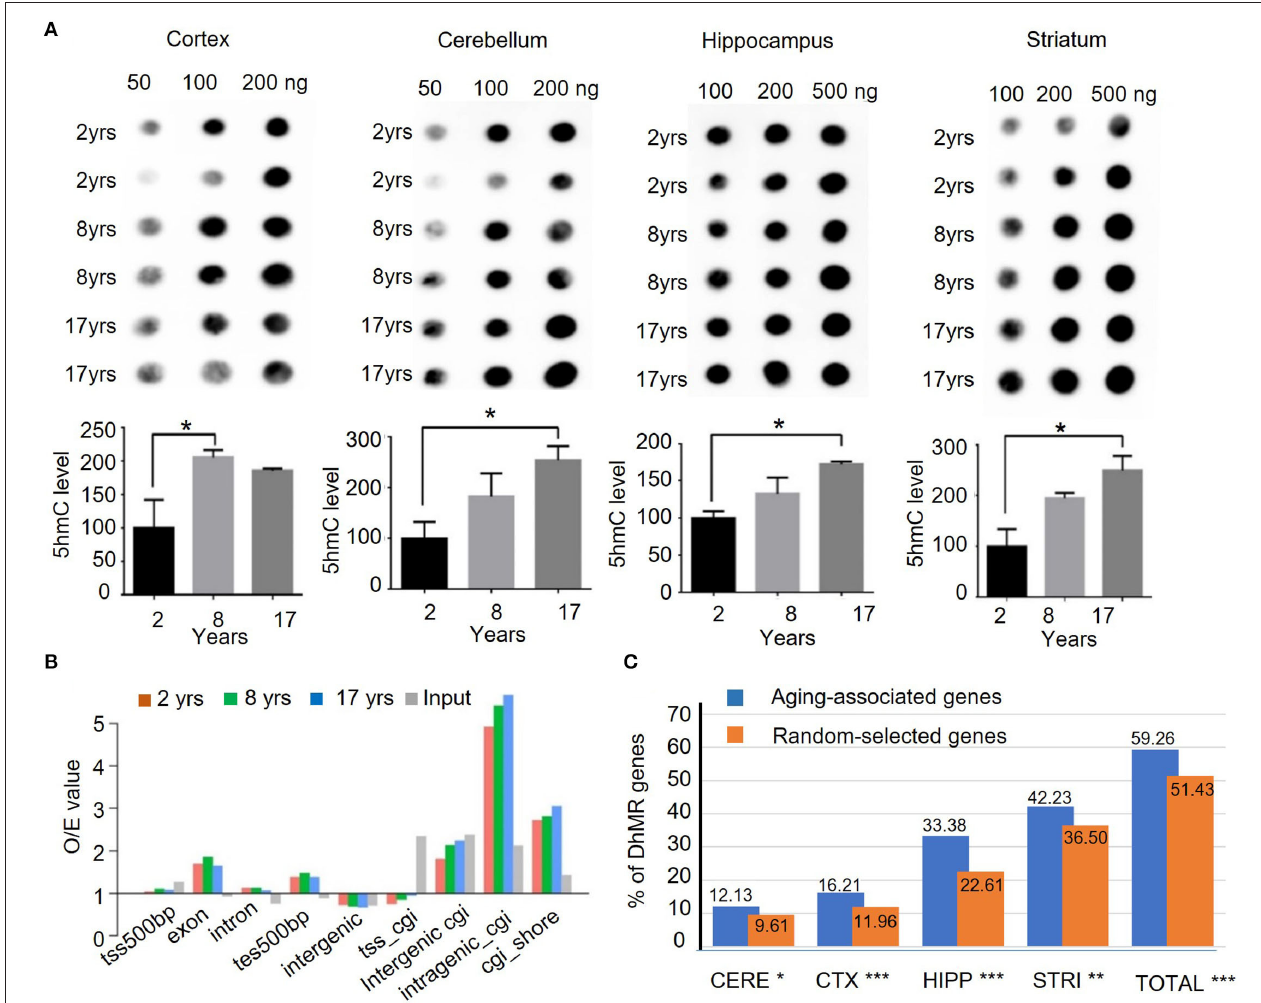
FIGURE 1 | Quantification and genomic mapping of 5hmC in four brain regions in rhesus monkeys. (A) 5hmC-specific dot blot revealed accumulation of 5hmC in cortex, cerebellum, hippocampus, and striatum of rhesus monkeys at 2, 8, and 17 years. Quantification of 5hmC-specific immunoblot by imageJ software in cortex, cerebellum, hippocampus, and striatum of rhesus monkeys. ( n = 2, * p < 0.05; unpaired t- test, error bar = mean ± SEM). (B) 5hmC distribution at different genomic components in 2-, 8-, and 17-year-old groups. (C) The ratio of genes with DhMRs to aging-associated genes (734) in different brain regions and the combined regions (totally). * p < 0.05, ** p < 0.01, *** p < 0.001; unpaired t- test.